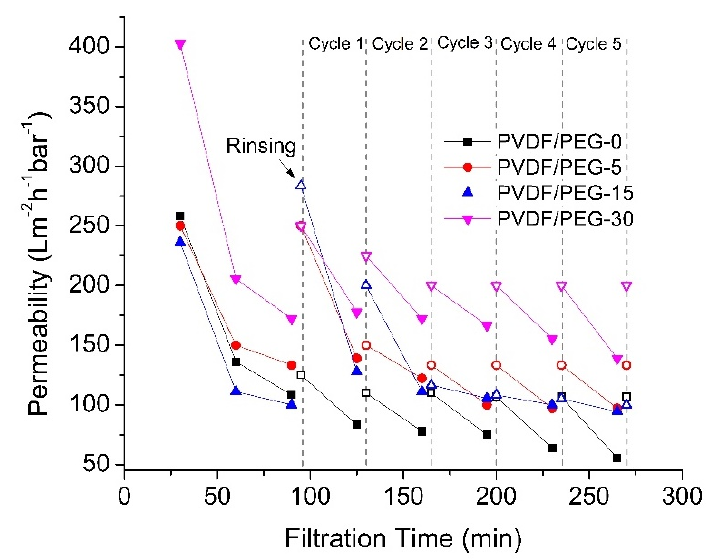
Figure 9. Permeability of the developed membranes treating PW with frequent water flushing.